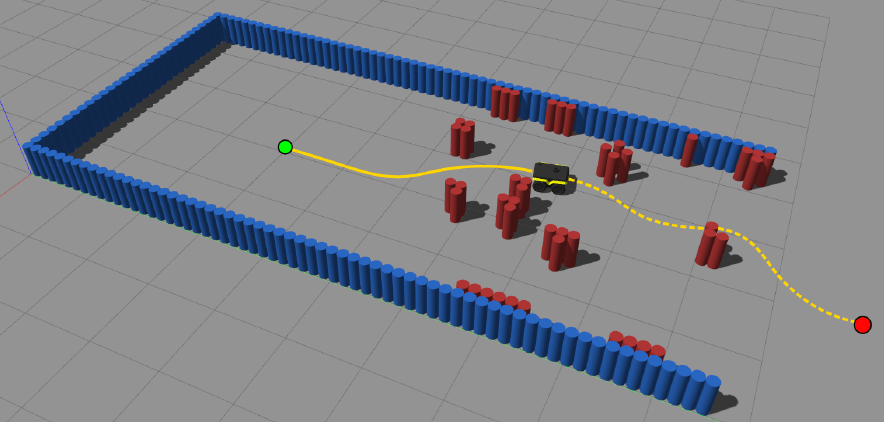
Figure 9. Environment #6 of the BARN dataset [49]. The objective is to exit the enclosed environment (blue cylinders), going from the start position (green dot) to the goal region (red dot) by traversing the cluttered area (red cylinders) as fast as possible.